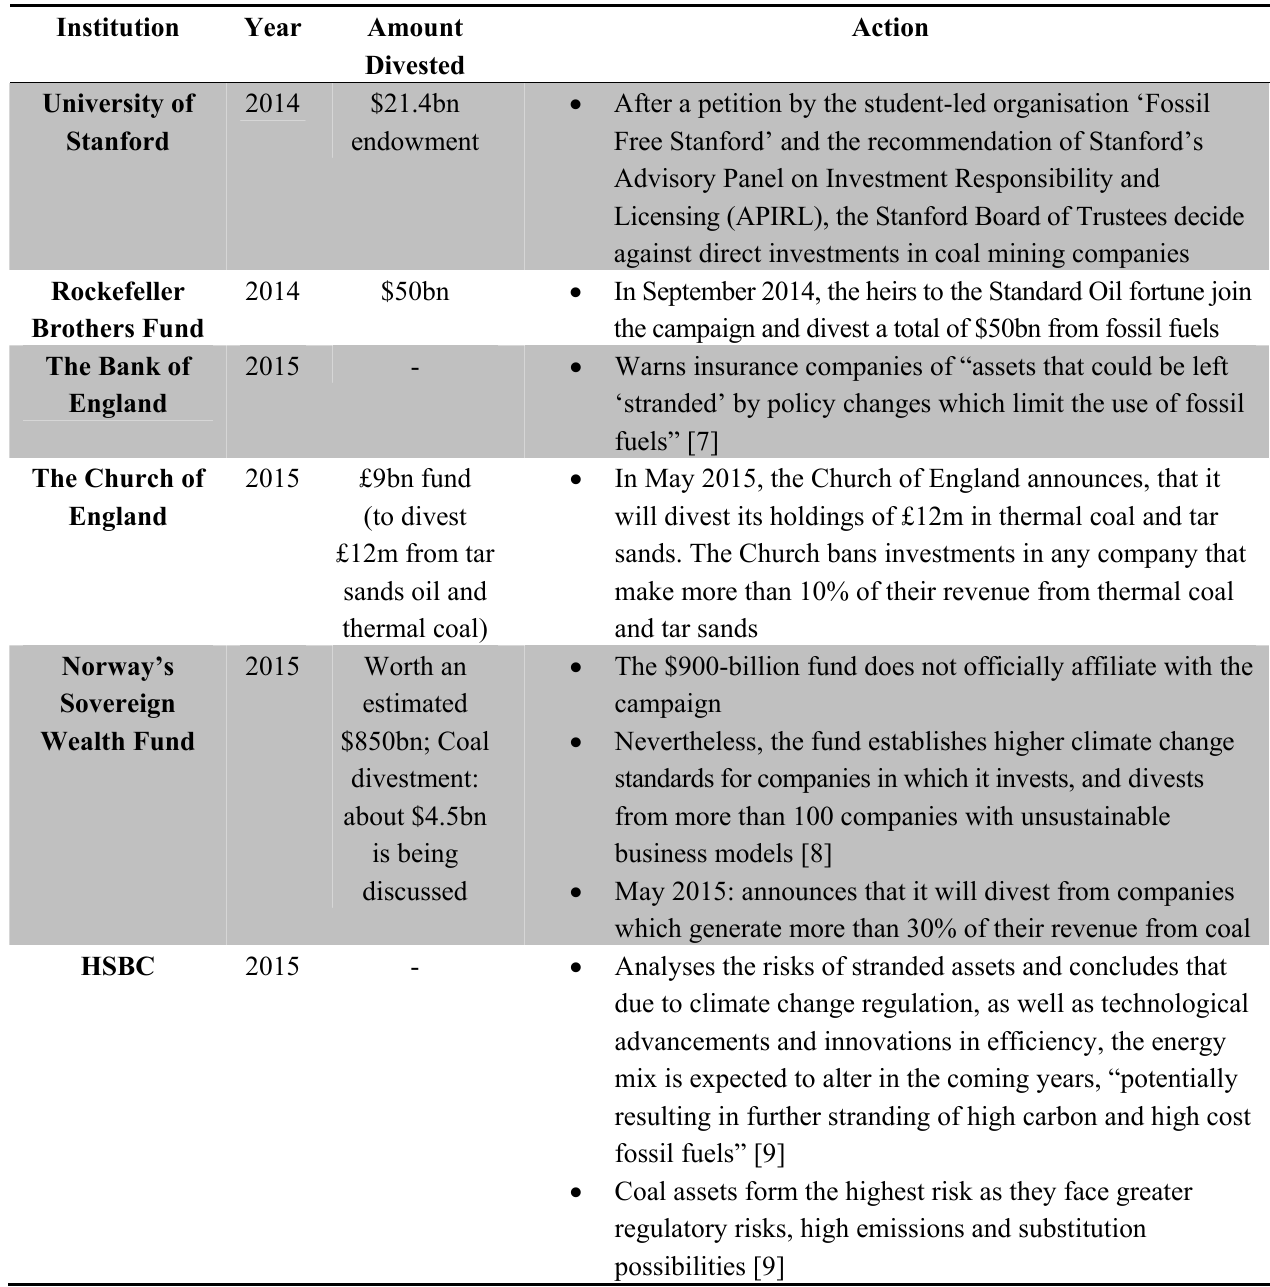
Table 1. Examples of institutions implementing fossil fuel divestment